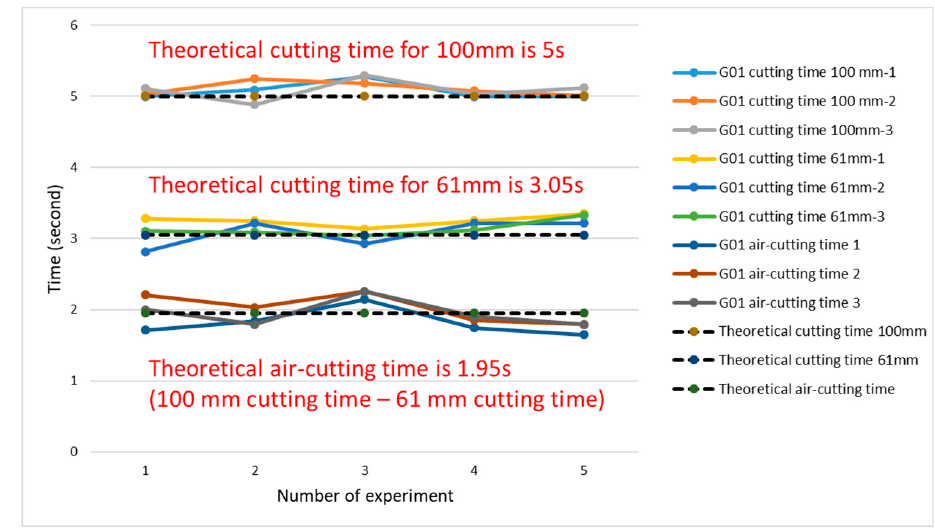
Figure 10. Results of verification experiment 2.